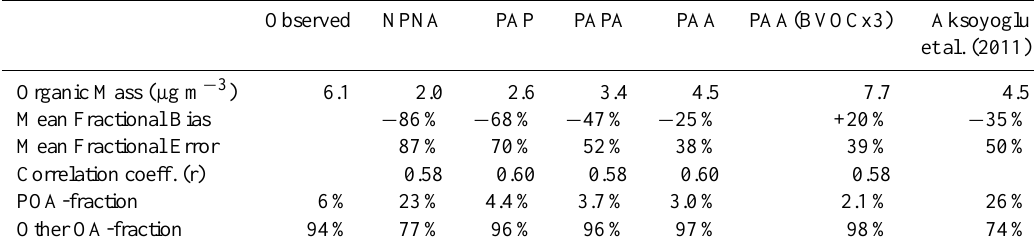
Table 6. Organic aerosol in fine particles at Payerne (Switzerland) for the period 31 May to 3 July 2006. Comparison of EMEP PCM model results to aerosol mass spectrometry measurements and a high-resolution model study (Lanz et al., 2010; Aksoyoglu et al., 2011). Statistics for 665 hourly measurements for the Organic Mass and monthly average Primary Organic Aerosol and Other (oxidised) Organic Aerosol fractions.